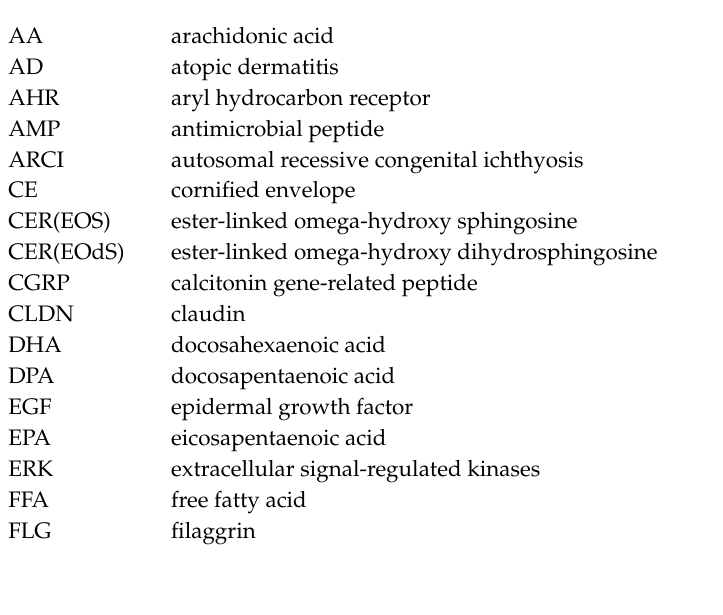
Funding: This work was supported by grants from the Austrian Science Fund and the Tyrol Research Fund to SD (FWF 28039, FWF